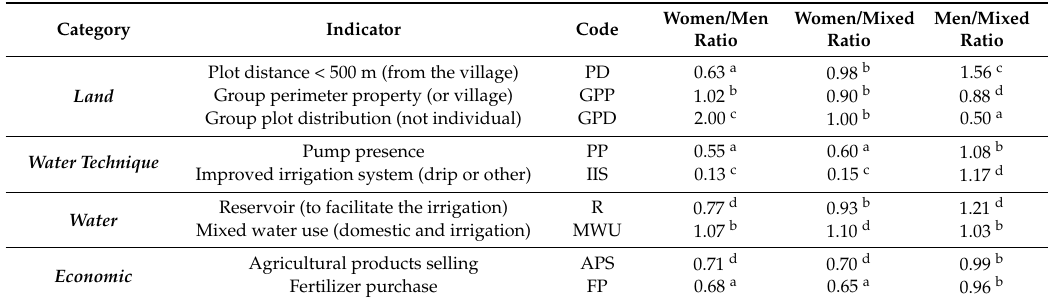
Table 5. The ratios of the investigated indicators and the different levels of inequality between the observed